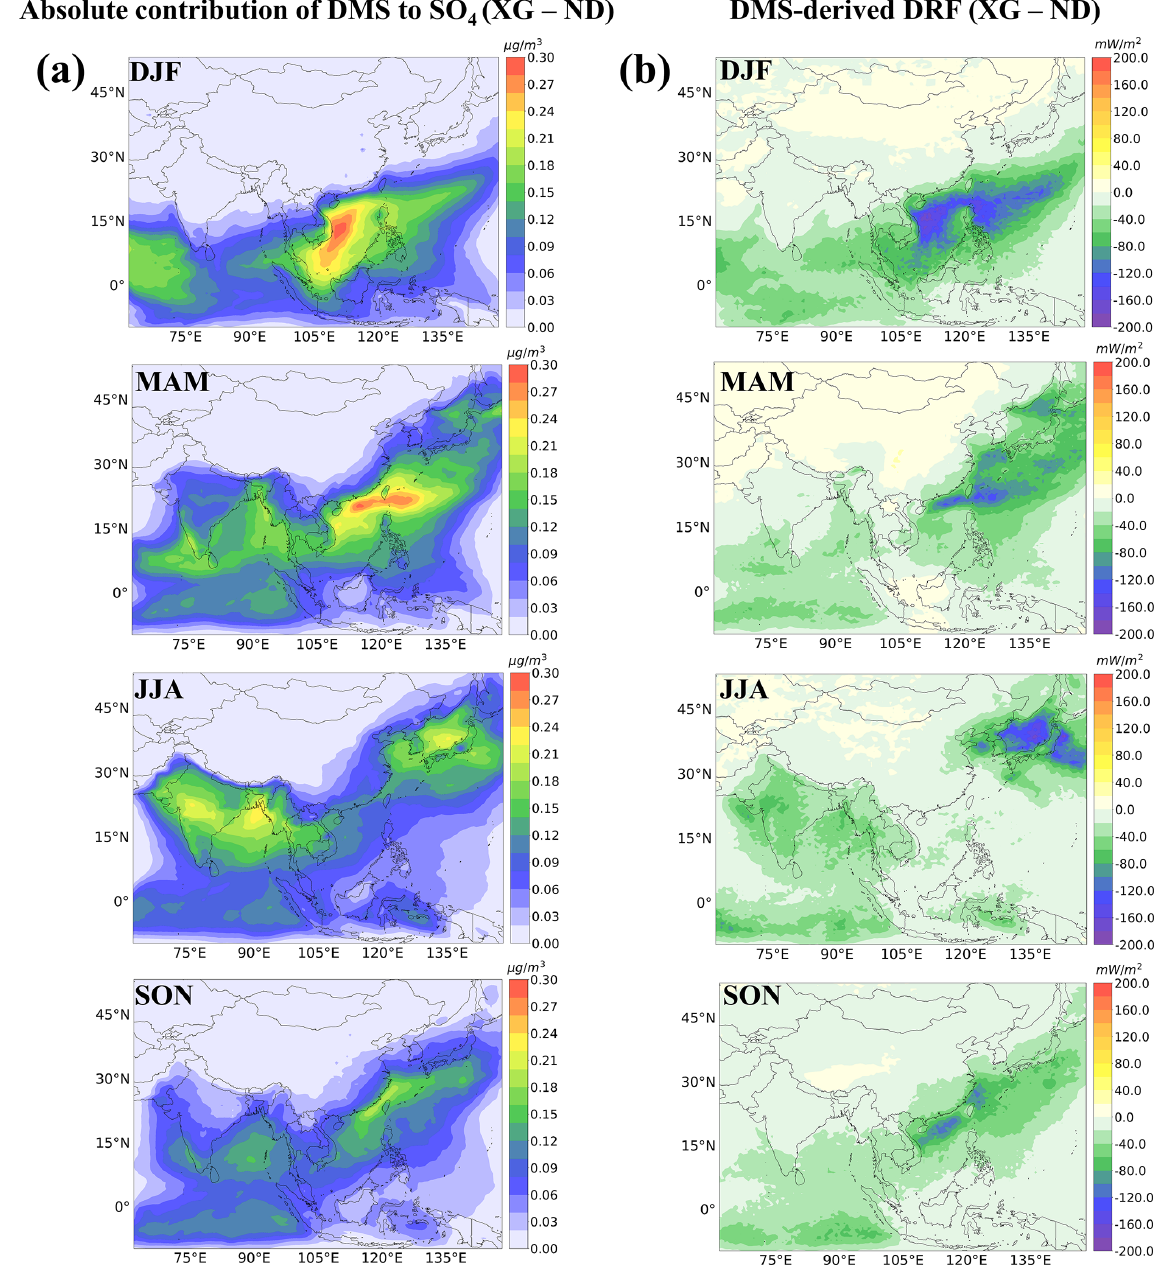
Figure 6. Spatial pattern of the seasonal mean absolute changes in surface SO 4 2 − (first column) and all-sky DRF (second column) between the XG and ND (no DMS)